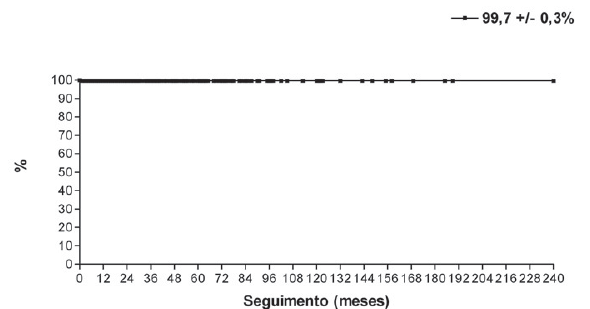
Fig. 2 - Curva atuarial livre de tromboembolismo